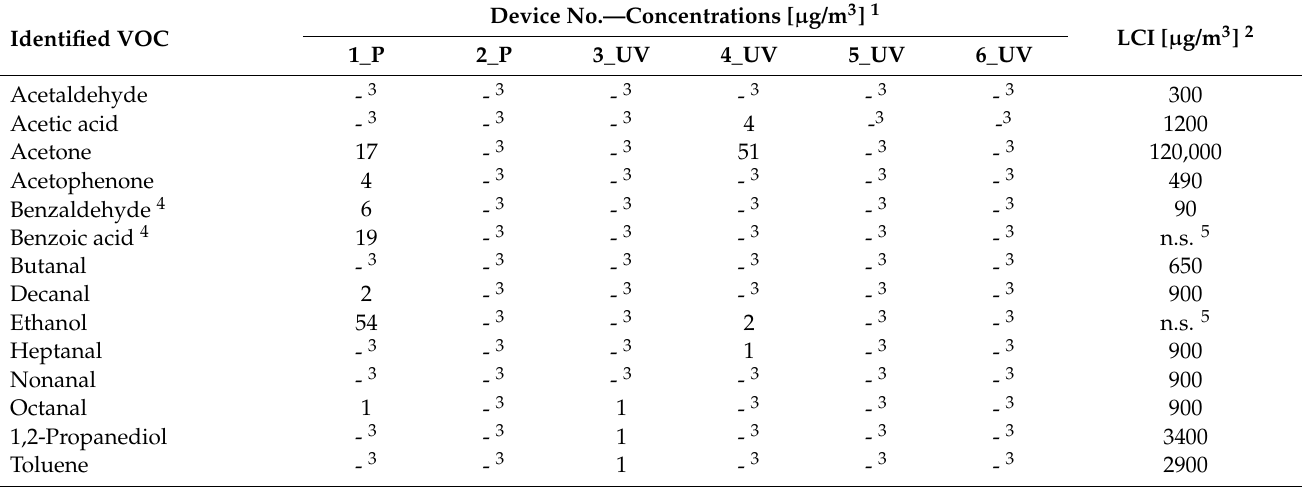
Table 3. VOC release during operation.